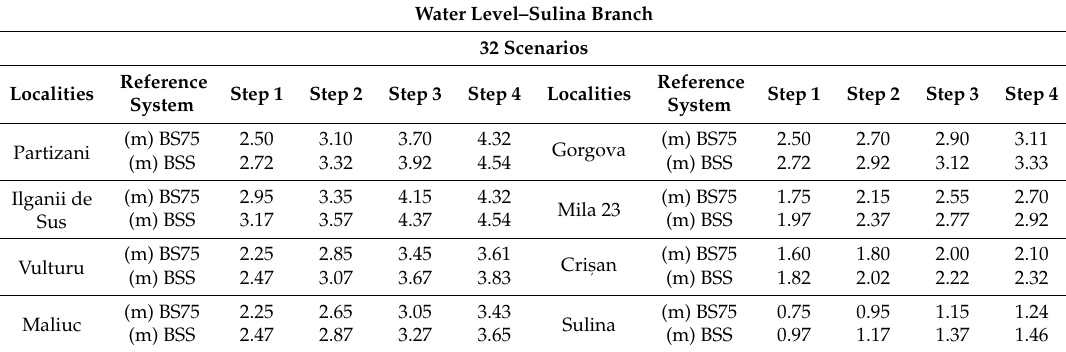
Table 4. Sets of flooding water levels in meters with reference to the Black Sea 75 (BS75) and the Black Sea Sulina (BSS), applied to the